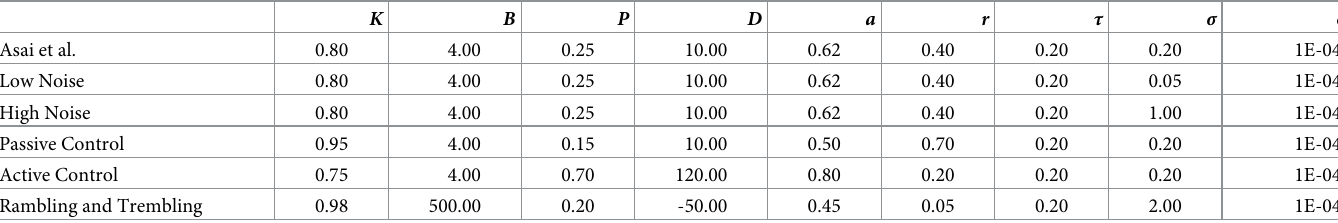
Table 3. Parameter sets for generating simulated